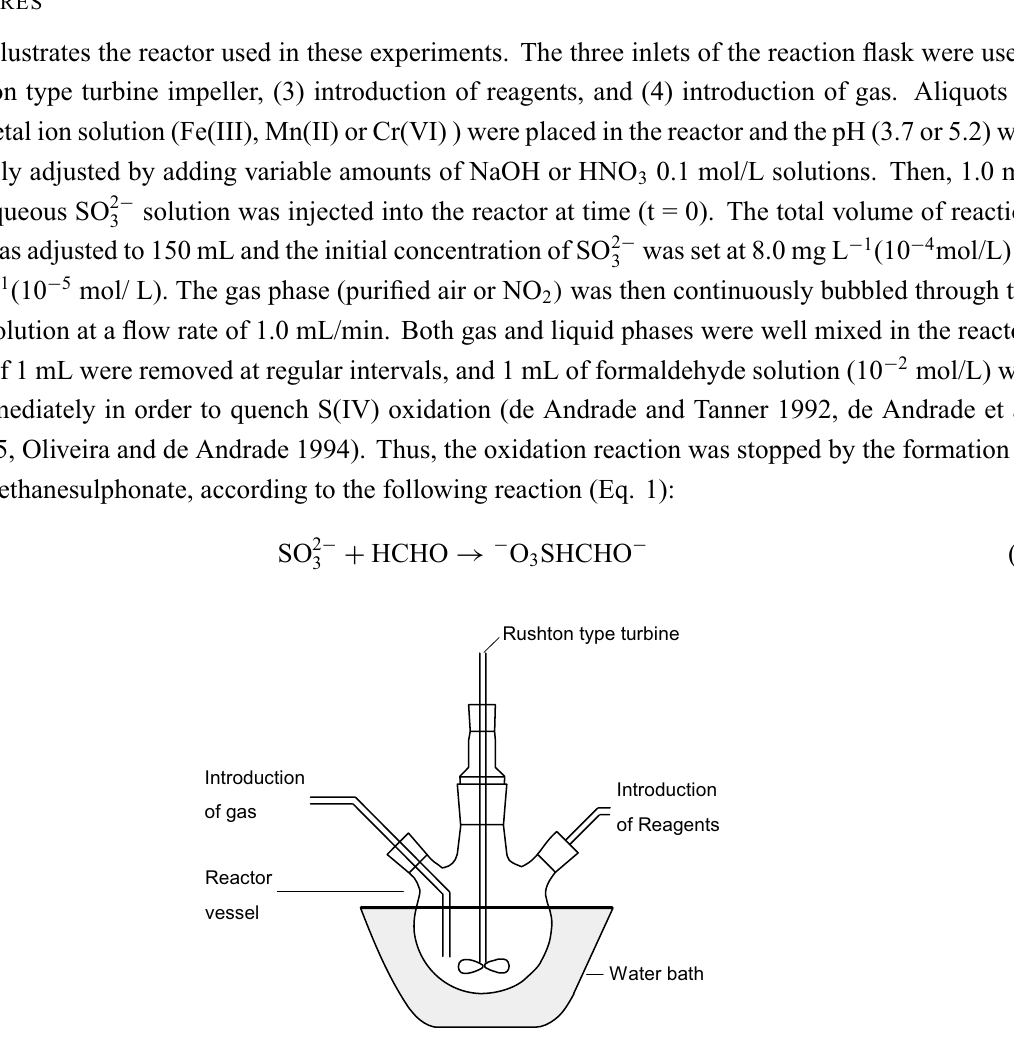
Fig. 1 – Apparatus for kinetics